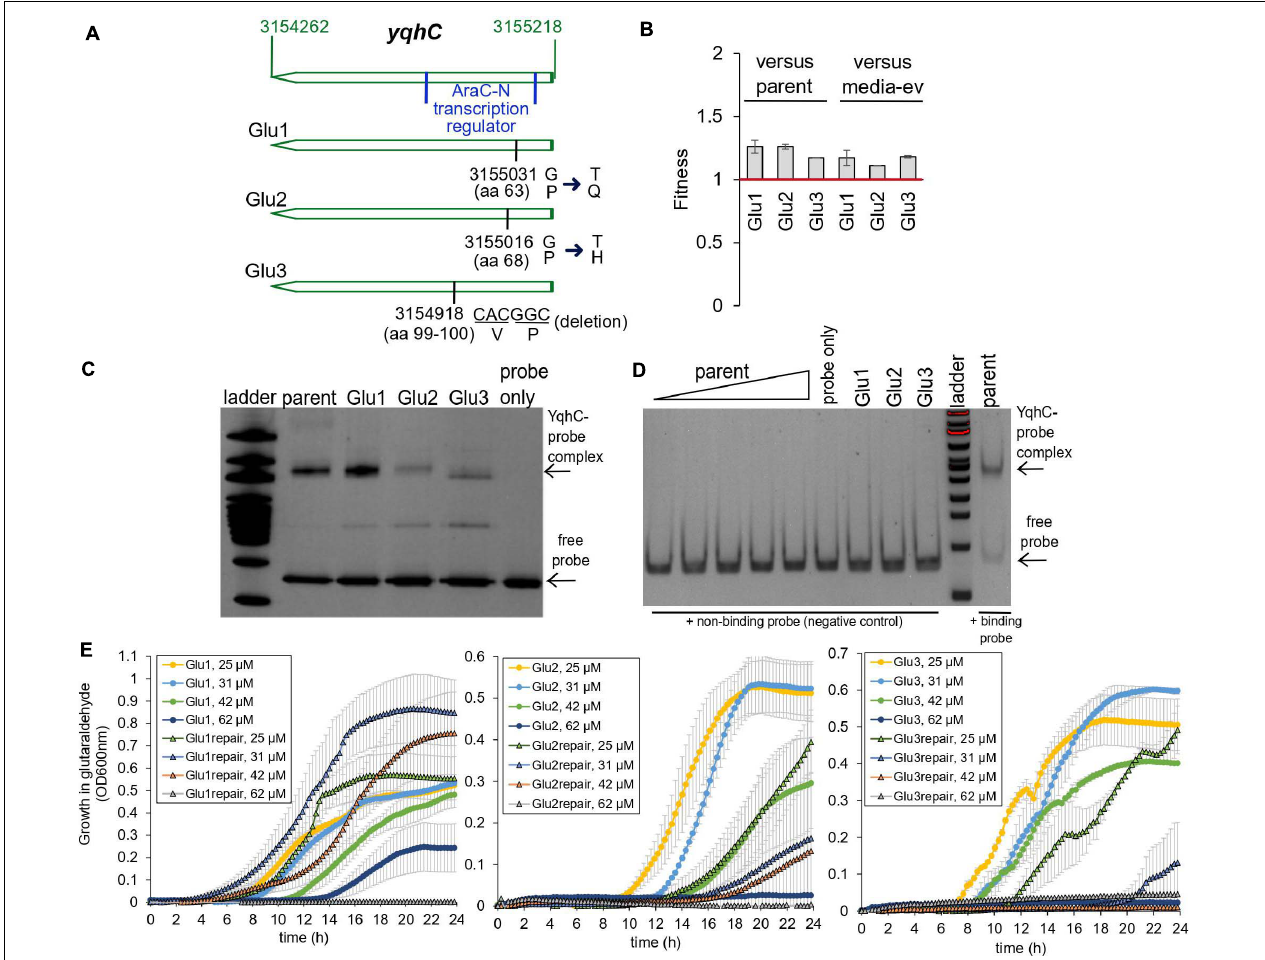
FIGURE 2 | Glutaraldehyde-evolved and tolerant E. coli MG1655 strains independently selected for mutations in yqhC . (A) Position information within the yqhC gene of the mutations observed for the evolved strains Glu1, Glu2, Glu3. The bases and amino acids (aa) mutated are indicated. (B) Fitness of glutaraldehyde-evolved strains over the parent or media-only evolved strains as measured in competition assays. Fitness above one denotes a fitness advantage. The experiment was performed in duplicate. (C) A representative gel-shift (EMSA) assay for each of the YqhC variants. The 100 bp DNA ladder (NEB) was applied to the gel for reference. The bottom arrow points to the free probe, and the top arrow indicates the YqhC protein bound to the DNA probe (promoter region of yqhD-dkgA operon). (D) A gel-shift (EMSA) assay with a negative-control DNA probe (non-binding DNA sequence) for reference. The concentration of protein for the parent YqhC was varied between 5 and 115 ng/ µ L. (E) Growth curves in M9 media with the presence of glutaraldehyde (concentrations indicated in the graph’s legend) for the evolved strains Glu1, Glu2 and Glu3 and their respective “repair” strains, in which the mutant yqhC was replaced with the wild-type version of the gene in the respective background strain. TABLE 1 | Summary of the differences observed for mutant strains compared to the parental strain when grown in minimal media containing the chemicals mentioned. Chemical and concentration Glu1 Glu2 Glu3 Potassium chromate (0.005–0.01 mM) Decreased MIC Slower growth (extended lag) Decreased MIC Potassium tellurite (20–60 mg/L) Decreased MIC No significant difference Higher max. growth Furfural (1–2 mM) Slower growth (extended lag) Slower growth (extended lag) Slower growth (extended lag) All strains were tested in